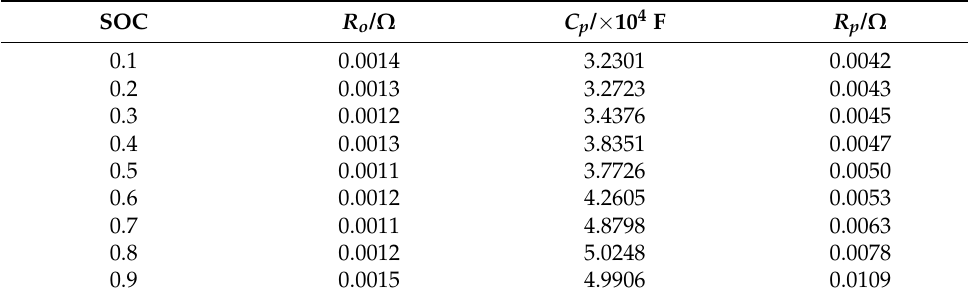
Figure 4. Model verification results. ( a ) Voltage prediction results of the lithium-ion battery. ( b ) Voltage prediction error of the battery model. ( c ) Voltage prediction results of the ultracapacitor. ( d ) Voltage prediction error of the ultracapacitor. Table 3. Battery parameter